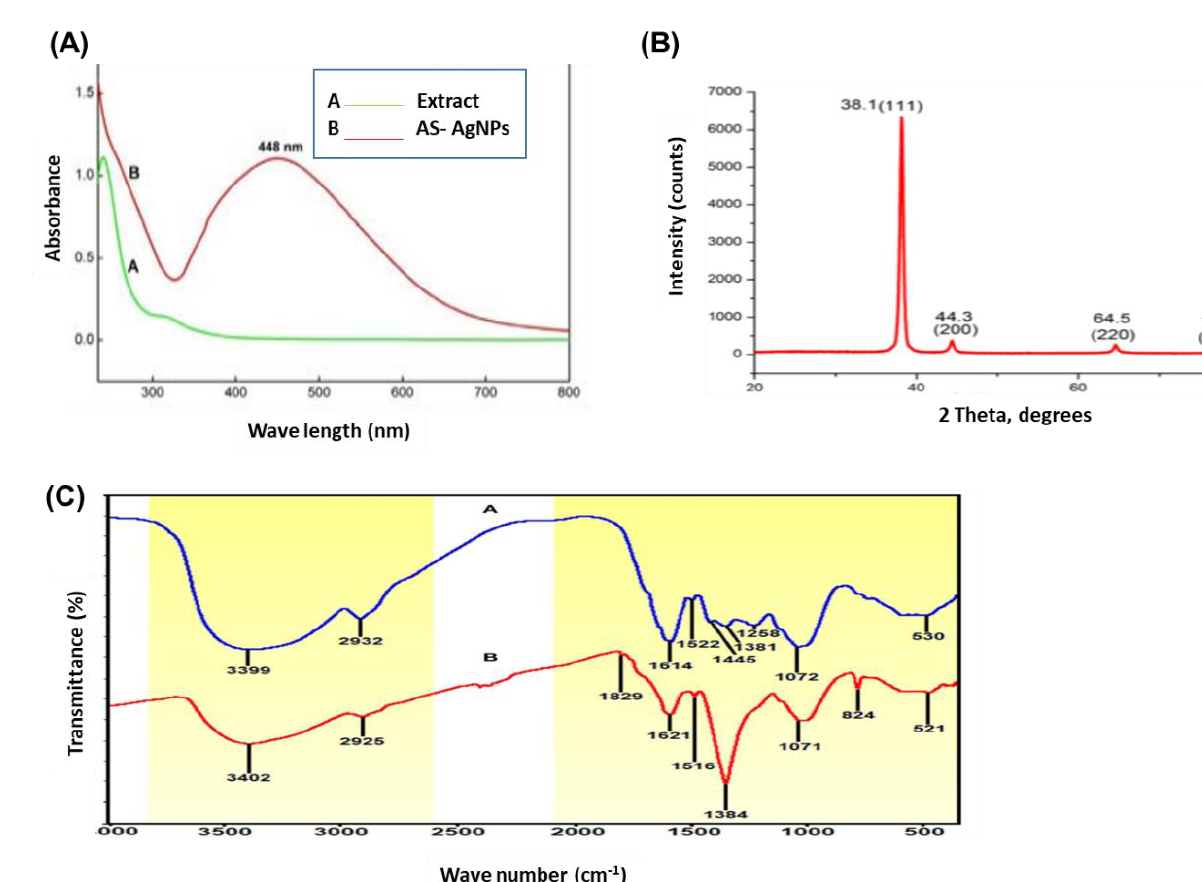
Figure 1. Biosynthesis of AS-AgNPs. Changes in color from yellowish brown to dark brown after the incubation of the A. santolina leaf extract and silver nitrate at room temperature in the dark.